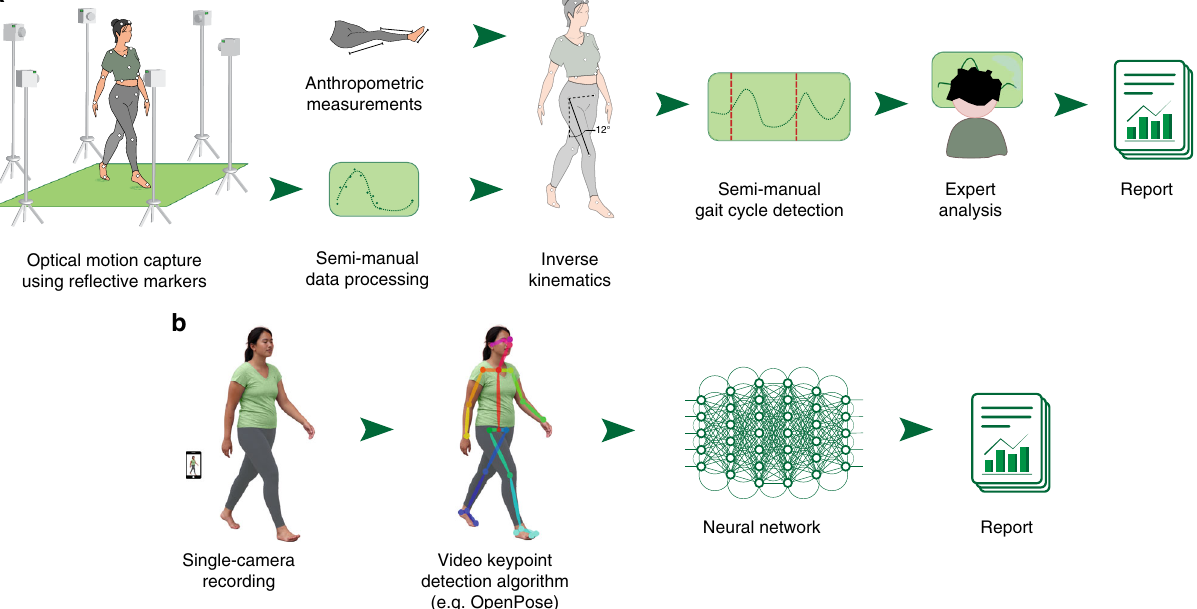
Fig. 1 Comparison of the current clinical work fl ow with our video-based work fl ow. a In the current clinical work fl ow, a physical therapist fi rst takes a number of anthropometric measurements and places re fl ective markers on the patient ’ s body. Several specialized cameras track the positions of these markers, which are later reconstructed into 3D position time series. These signals are converted to joint angles as a function of time and are subsequently processed with algorithms and tools unique to each clinic or laboratory. b In our proposed work fl ow, data are collected using a single commodity camera. We use the OpenPose 14 algorithm to extract trajectories of keypoints from a sagittal-plane video. We present an example input frame, and then the same frame with detected keypoints overlaid. To illustrate the detected pose, the keypoints are connected. Next, these signals are fed into a neural network that extracts clinically relevant metrics. Note that this work fl ow does not require manual data processing or specialized hardware, allowing monitoring at